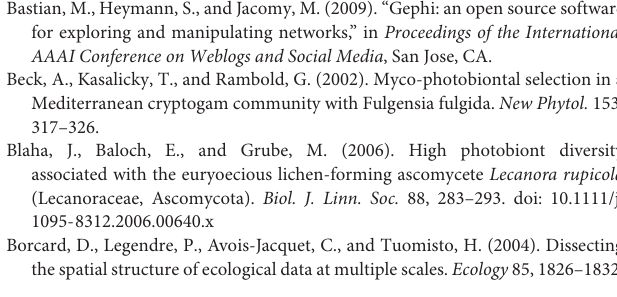
Supplementary Figure 1 | Summary of the three species delimitation analyses (GMYC, bPTP, and ABGD) using mycobiont nrITS sequences. The topology shown corresponds to the Bayesian ultrametric tree obtained in BEAST. Each color corresponds to the different fungal species delimited. Supplementary Figure 2 | Trebouxia phylogenetic analysis. Rooted LSU rDNA gene tree representing 139 Trebouxia sequences, including 9 well − accepted Trebouxia species from SAG and UTEX retrieved from the GenBank. Newly generated sequences are marked as ex Parmelia spp._locality-code number. Seven Trebouxia species detected were indicated. Values at nodes indicate statistical support estimated by two methods: bootstrap support (BS, RAxML analysis) and posterior probabilities (PP, MrBayes analysis). Scale bar shows the estimated number of substitutions per site. Supplementary Figure 3 | Summary of the three species delimitation analyses (GMYC, bPTP, and ABGD) using concatenated phycobiont nrITS and LSU DNA dataset. The topology shown corresponds to the Bayesian ultrametric tree obtained in BEAST. Each color corresponds to the different algal species delimited. Supplementary Figure 4 | (A) Network diagram showing the location of the seven clusters (1–7) (B) Venn’s diagram showing the variation in distribution of the clusters explained by effects of climate, geography and substrate. Supplementary Figure 5 | PCA result of seven clusters distribution depending on climatic factors. Large circles represent group centroids. Climatic data were obtained from the Global Climate Data—WorldClim. BIO1, Annual Mean Temperature; BIO2, Mean Diurnal Range [Mean of monthly (max temp—min temp)]; BIO3, Isothermality (BIO2/BIO7) ( × 100); BIO4, Temperature Seasonality (standard deviation × 100); BIO5, Max Temperature of Warmest Month; BIO6, Min Temperature of Coldest Month; BIO7, Temperature Annual Range (BIO5-BIO6); BIO8, Mean Temperature of Wettest Quarter; BIO9, Mean Temperature of Driest Quarter; BIO10, Mean Temperature of Warmest Quarter; BIO11, Mean Temperature of Coldest Quarter; BIO12, Annual Precipitation; BIO13, Precipitation of Wettest Month; BIO14, Precipitation of Driest Month; BIO15, Precipitation Seasonality (Coefficient of Variation); BIO16, Precipitation of Wettest Quarter; BIO17, Precipitation of Driest Quarter; BIO18, Precipitation of Warmest Quarter; BIO19, Precipitation of Coldest Quarter. Supplementary Table 1 | Samples used in this study, with details on collection data, herbarium codes and the GenBank accession numbers for the sequences generated for the nrITS (mycobiont and microalgae) and LSU